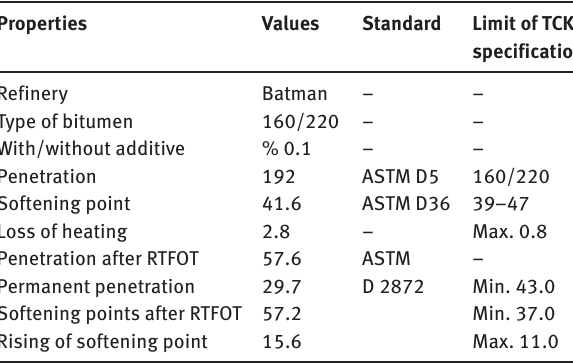
Table 4: Binder properties used in test roads.